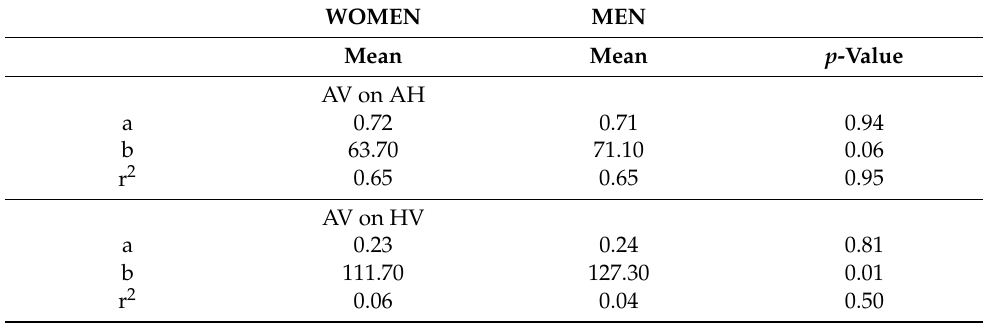
Table 6. Comparison of AV~AH and AV~HV dependencies between men and women.